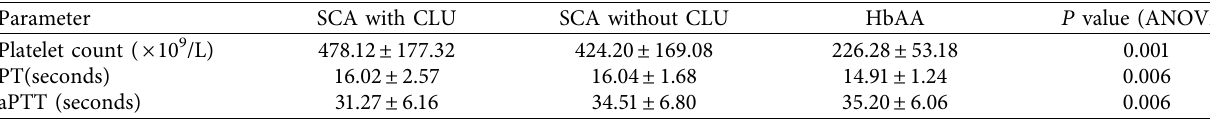
Table 2: Coagulation profile of study subjects.